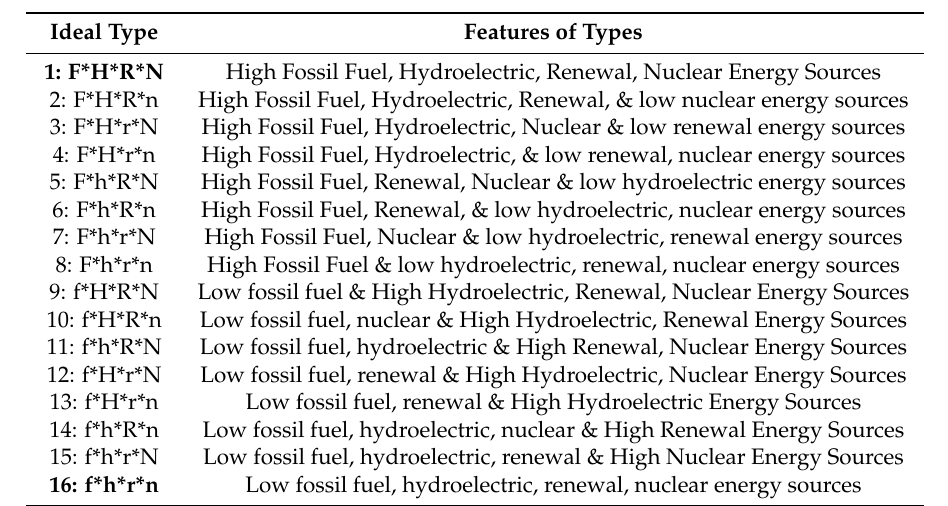
Table 2. The Sixteen Ideal Type Sets.